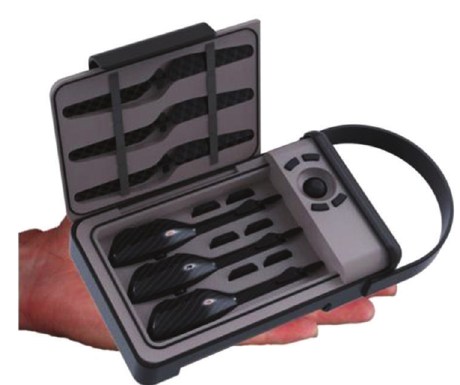
Figure 25: Graphic representation of the GCS from Prox Dynamics, containing three NAVs in the bottom side while the controls and the LED screen are placed on the upper side